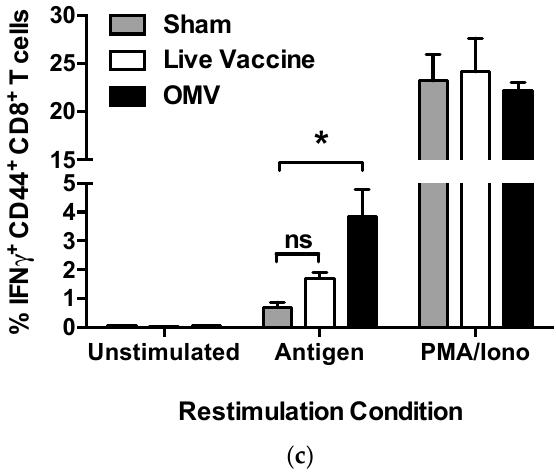
Figure 4. OMV immunization induces antigen-specific mixed Th1/Th17 CD4 T cells and CD8 T cells in mice. Antigen-specific CD4 and CD8 T cell responses were measured in the spleens of mice ( n = 3 per group) immunized with sham, live vaccine, or OMV by flow cytometry (* p < 0.05 ** p < 0.01 *** p < 0.001 by one way ANOVA, ns = not significant). Cells were gated using granularity to include